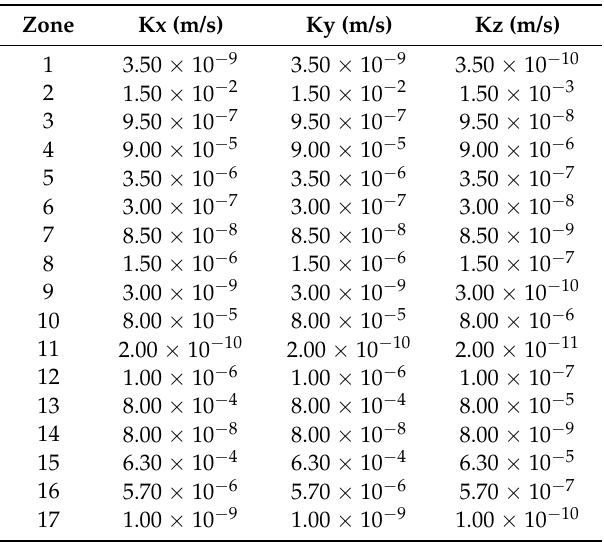
Table 2. Initial hydraulic conductivity, K, for model.